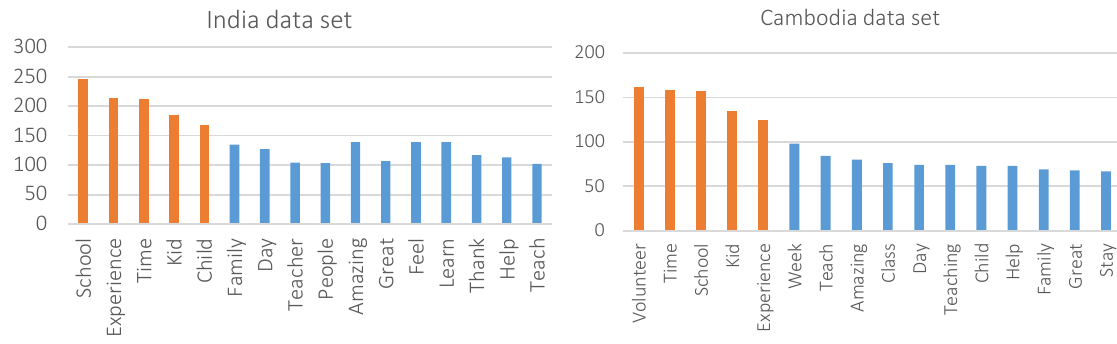
Figure 2. Frequency count of words with logarithmic trend line